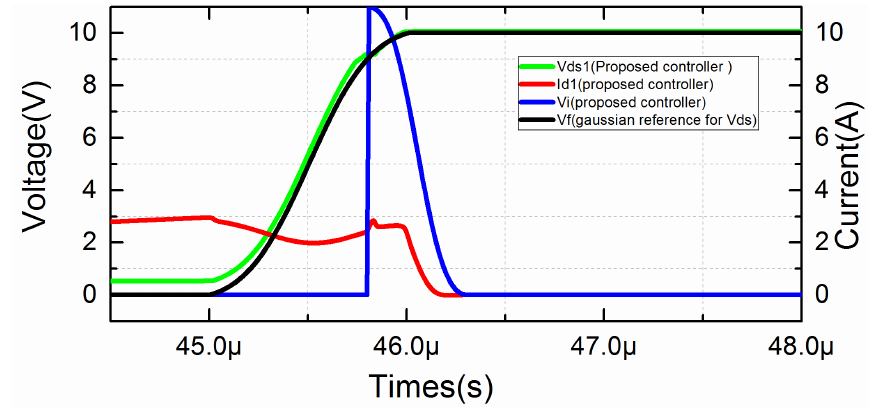
Figure 12. Pspice simulation SiC MOSFET during turn-off with 1 µs decline time of V f and 0.5 µs rise